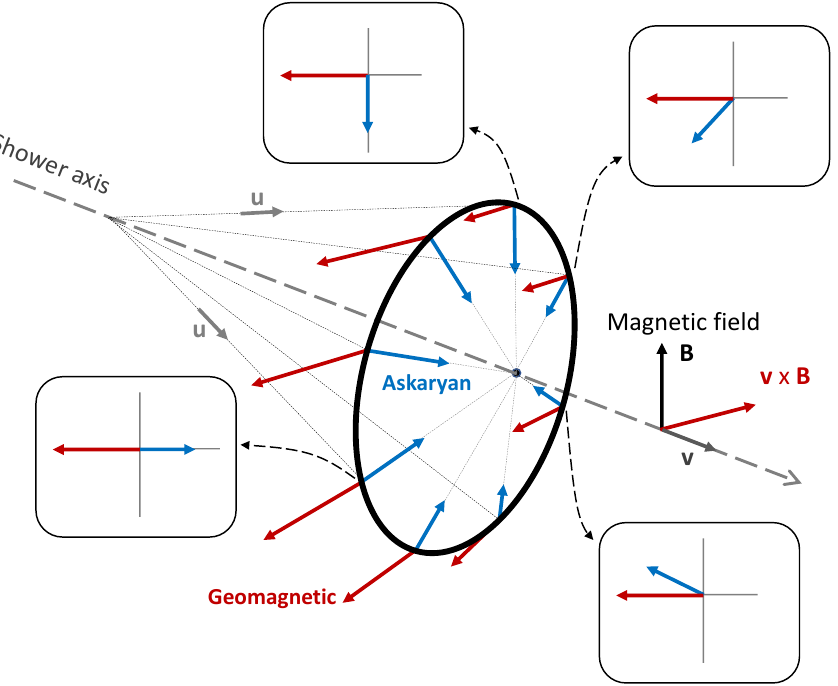
Figure 8. Sketch of the shower axis along the direction v , the geomagnetic field B and the polarization of the electric field due to the geomagnetic mechanism (red vectors parallel to ˆu × [ ˆu × ( v × B )] , see text), and to the Askaryan mechanism (blue vectors radially inwards pointing to shower axis). The amplitudes of the geomagnetic and Askaryan fields drawn are for illustrative purposes only and not to